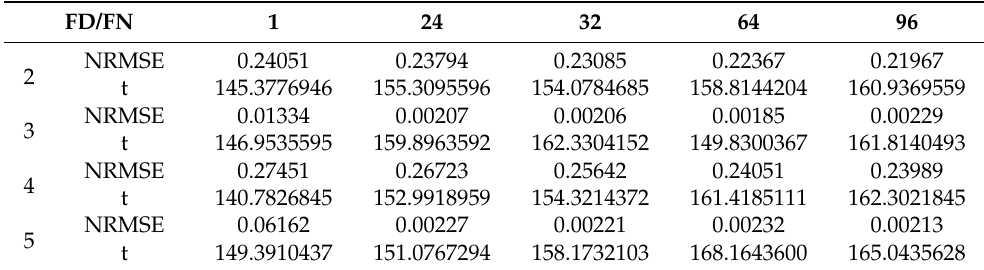
Table 2. An overview of the results obtained when using the architectures comprising 6 convolutional layers, 6 batch normalization layers and 6 ReLU layers, FD ∈ { 2,3,4,5 } , FN ∈ { 1,24,32,64,96 } , NHH = 500, trained using the ADAM training algorithm for the BiLSTM layer (t is measured in